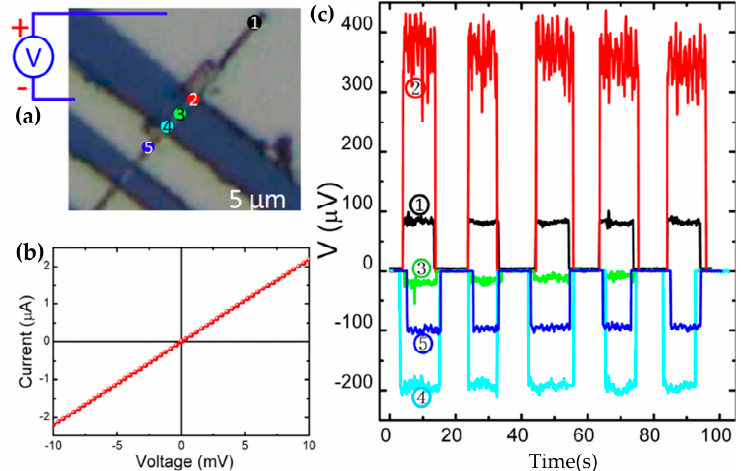
Figure 10. Photovoltage generation from a single Bi 2 Se 3 nanoribbon device with vertically incident linearly polarized light: ( a ) Typical optical image of a Bi 2 Se 3 nanoribbon device; ( b ) I − V curve of a typical Bi 2 Se 3 nanoribbon device; ( c ) Photovoltage response with switching on/off the laser illumination [134].